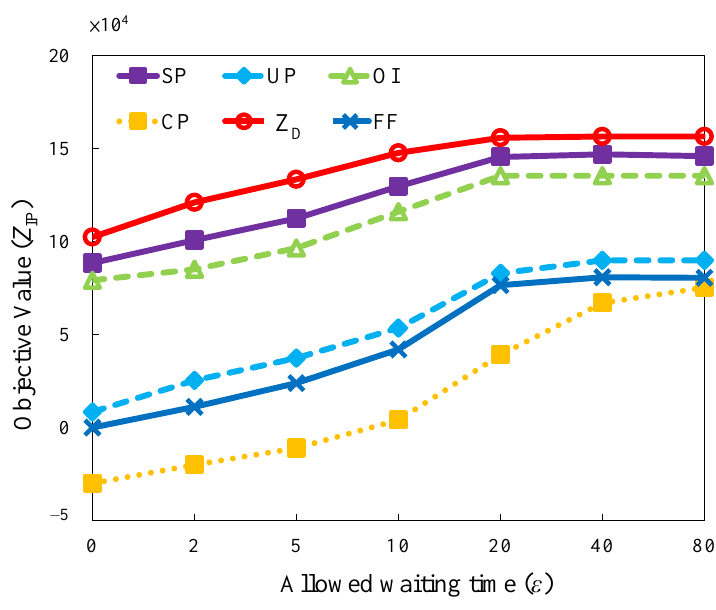
Figure 10. Objective value versus different allowed waiting